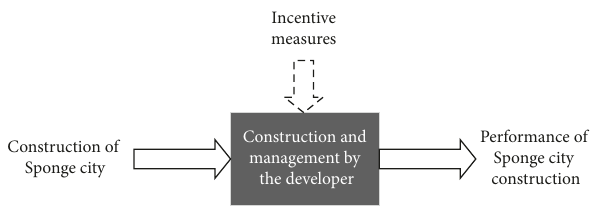
Figure 2: Black box of developer construction and